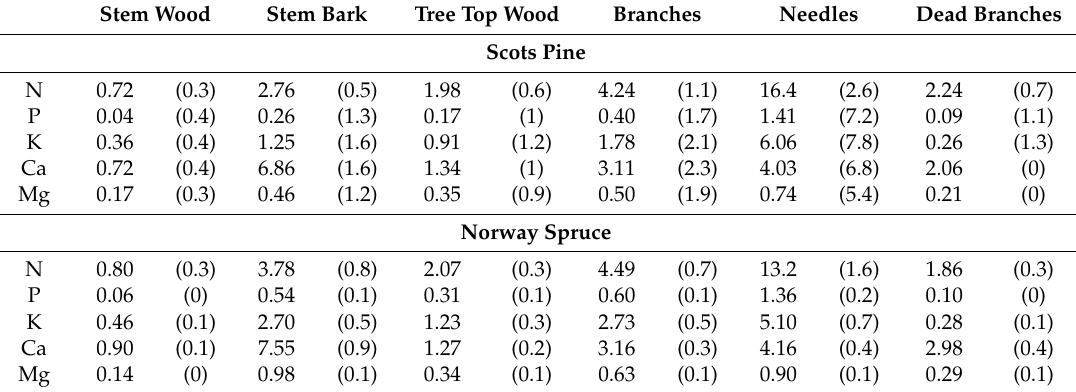
Table 5. Nutrient contents (g · kg − 1 ) of aboveground biomass compartments of pine and spruce trees at the trial sites in East Saxony. Means and standard deviation, n =